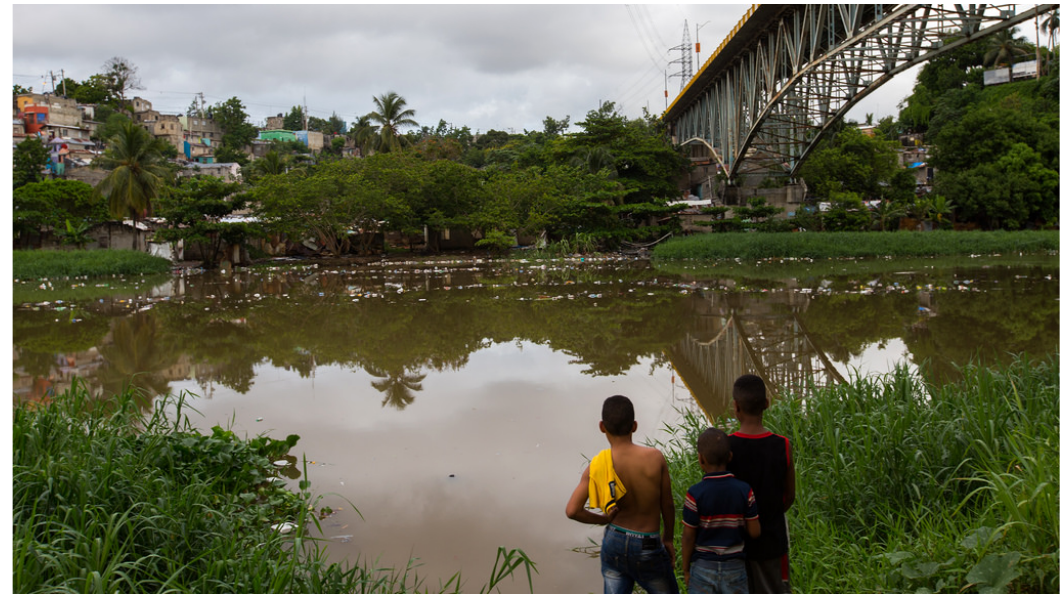
Figure 3. La Vieja Barquita neighbourhood and the Ozama River in Santo Domingo. Source: URBE (2017). Urban Planning, 2019, Volume 4, Issue 1, Pages